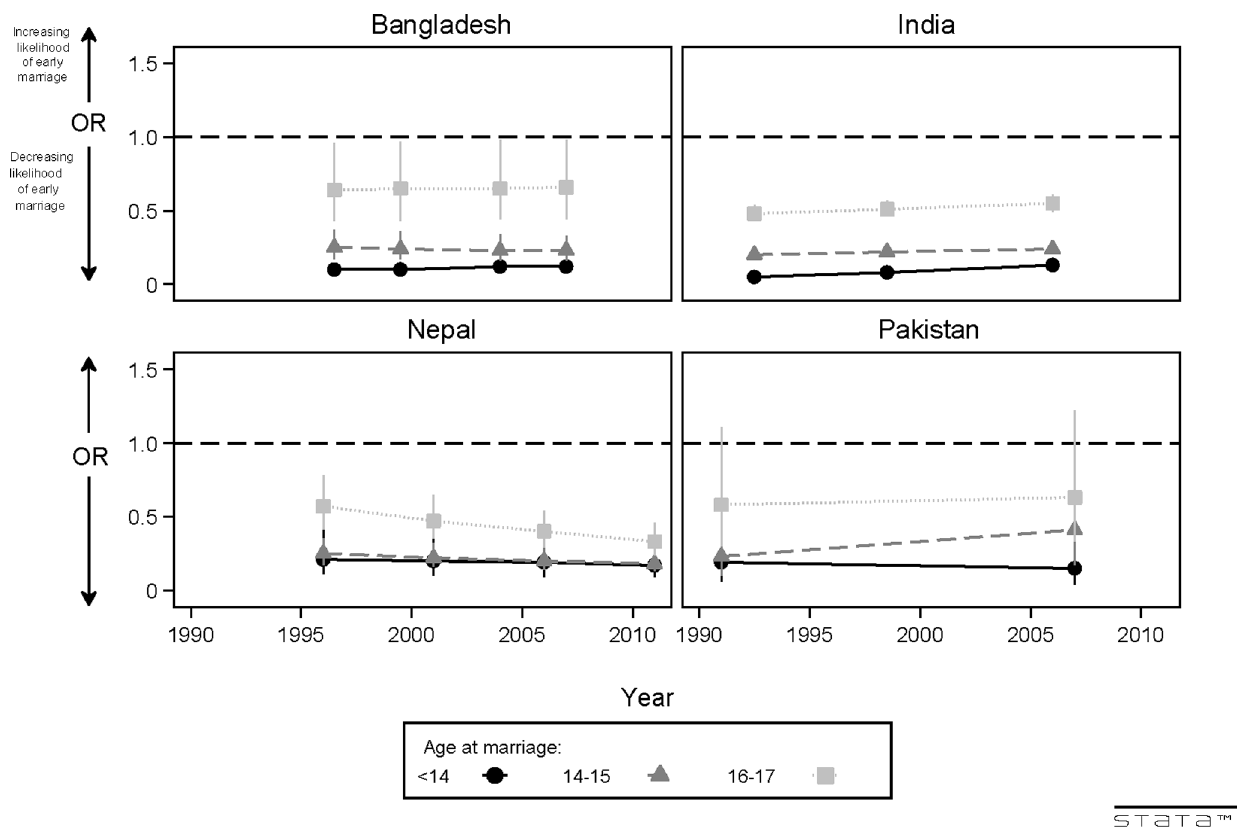
Figure 2. Adjusted odds ratios showing associations between secondary education and girl child marriage, 1991 to 2011. doi:10.1371/journal.pone.0106210.g002 PLOS ONE |